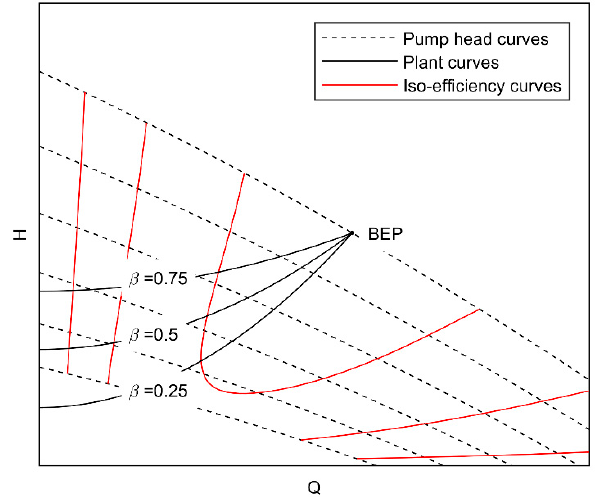
Figure 10. Pump head curves and plant curve depending on β .